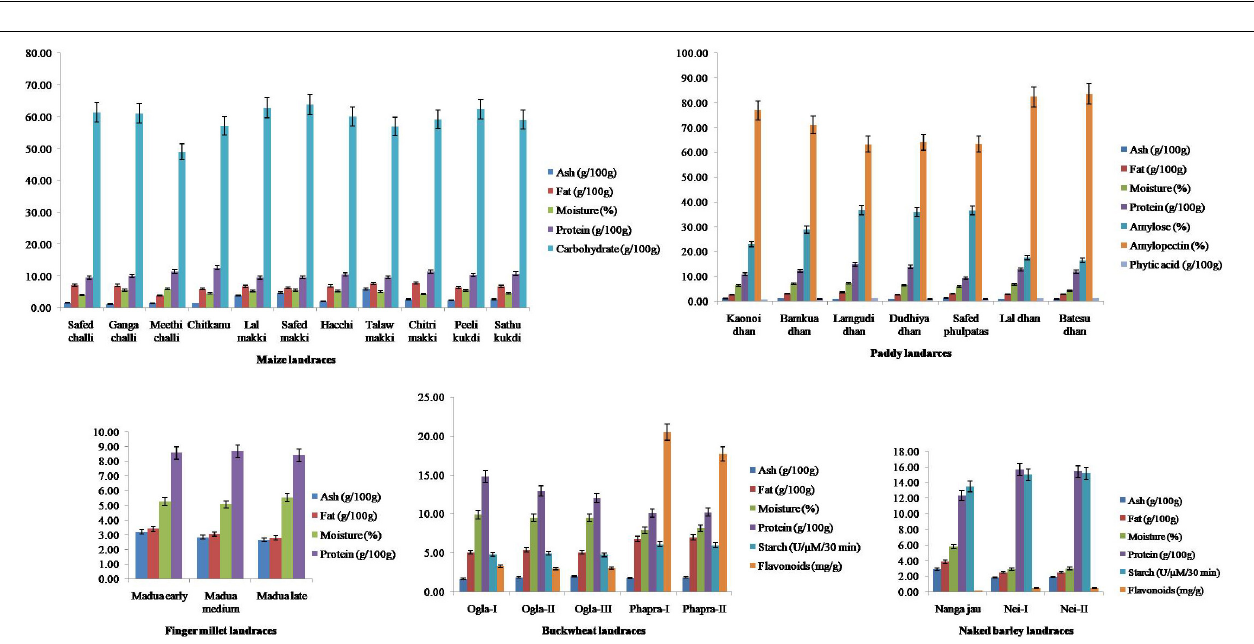
FIGURE 2 | Comparison of nutritional attributes of traditional crop landraces from northwest Indian Himalayas. Error bars represent mean ± SD for data recorded in triplicates (repeated